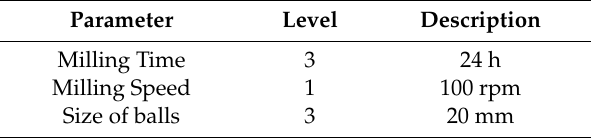
Table 6. Optimum